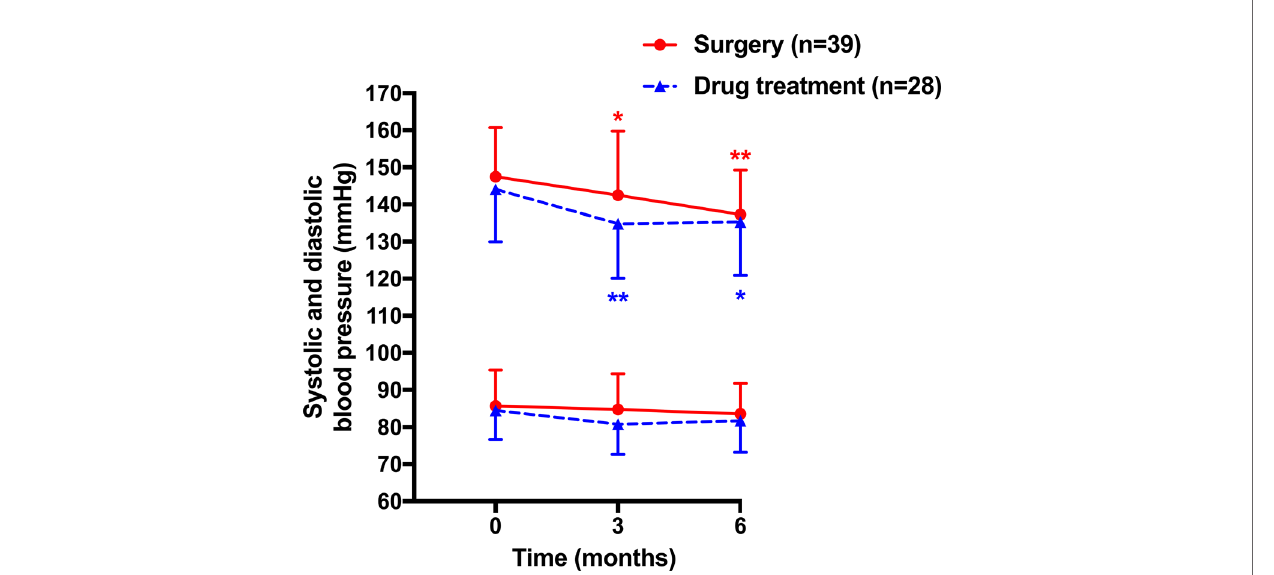
FIGURE 2 | Mean (± SD) values of systolic (upper lines) and diastolic blood pressure (lower lines) at baseline and during follow-up in patients treated with surgery (circles with solid lines) and drugs (triangles with dashed lines). * p < 0.05, ** p < 0.01 vs .